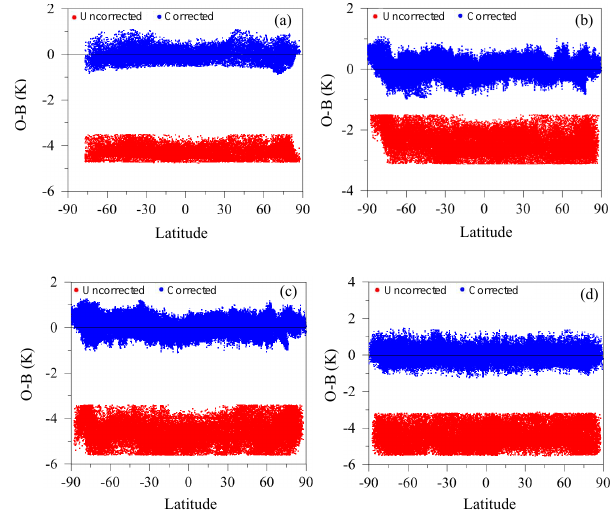
Figure 11. Scatter plots of uncorrected (red) and corrected (blue) O- B with latitude for MWTS-2 (a) channel 5, (b) channel 6, (c) chan- nel 7, and (d) channel 8 during 1–5 July